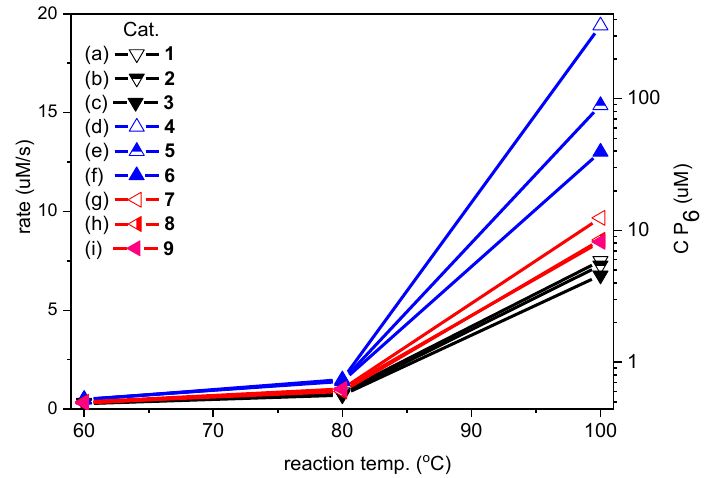
Figure 8. Reaction rate ( µ M/s) and the concentration of benzaldehyde accumulated after 6 h of reaction time (CP 6 , mM) for the catalytic oxidation of neat toluene: 0.1 mM of complexes 1 – 9 were used as catalysts in various reaction temperatures.